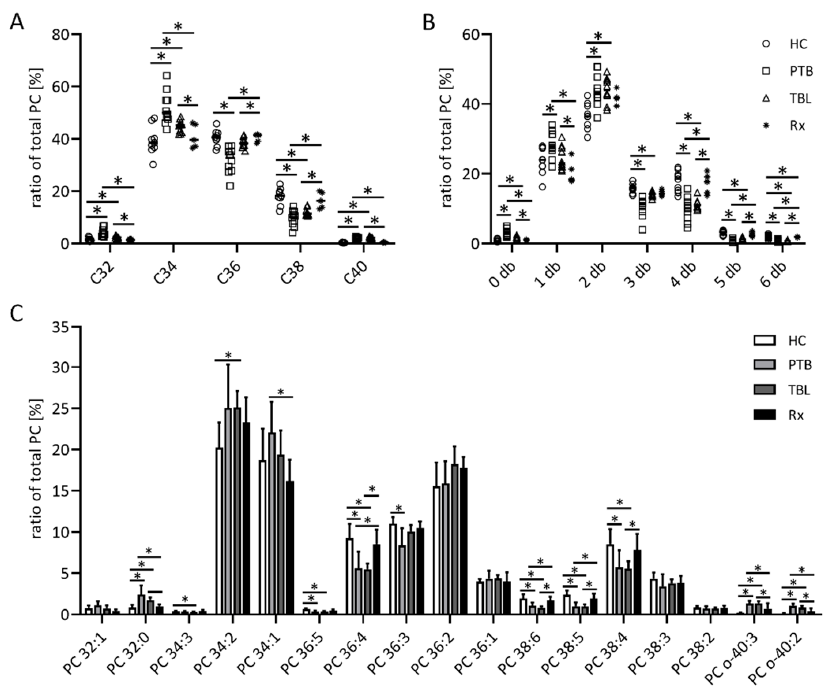
Figure 4. Composition of the phosphatidylcholine (PC) fraction of exosomes from TB patients. Organic extracts of exosome-derived lipids isolated from patients with pulmonary tuberculosis (PTB) and tuberculous lymphadenitis (TBL) as well as PTB-treated patients (Rx) were separated by high-performance thin layer chromatography. PC-containing spots were automatically eluted with methanol and directly analyzed by ESI-IT MS. ( A ) The sum of PC species with 32, 34, 36, 38 and 40 C atoms ( A ) and the sum of PC species with a certain amount of double bonds (db) in their fatty acyl residues ( B ) as well as the relative amounts of single PC species ( C ) were calculated from the sum of the signal intensities of all PC. Data sets in ( A ) and ( B ) are depicted as dot plots to show all single values, data sets in ( C ) are depicted as bar graphs showing the mean and the positive standard deviation. Statistical significance was determined using the unpaired t test and the Holm–Sidak method to correct for multiple comparisons (alpha = 0.05). * p < 0.05.